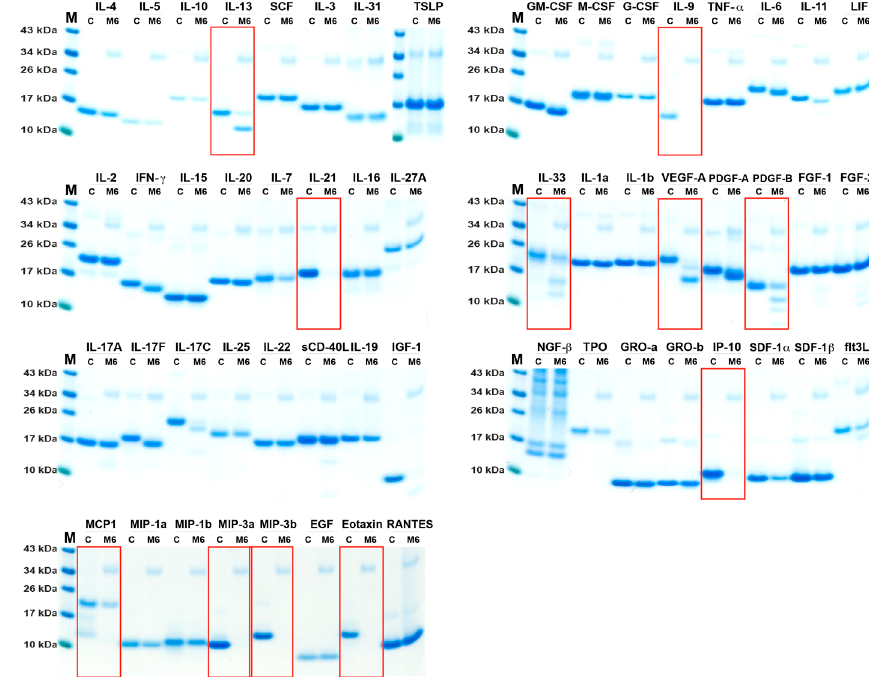
Figure 3. Cleavage analysis of a panel of 56 recombinant mouse cytokines and chemokines. The various recombinant cytokines and chemokines in buffer solution were divided into two separate tubes. One was kept as negative control (C) where PBS (no enzyme) was added and one was cleaved with the mouse tryptase (mMCP-6). The cleavage was performed at 37 °C in PBS at pH 7.3 for 2.5 h. The samples were separated on 4–12% SDS-PAGE gels under reducing conditions. Size markers are found at the left side of each gel. The gels were stained in colloidal Coomassie blue solution. The cytokines and chemokines that were efficiently cleaved or trimmed are marked by red rectangles.